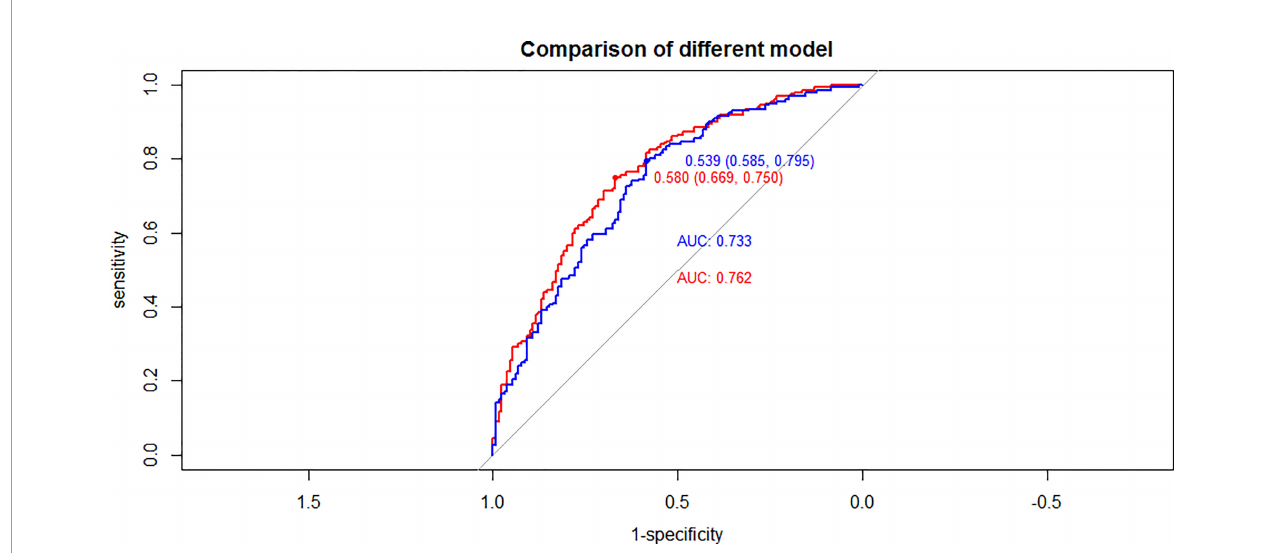
FIGURE 1 | Compared of ROC curves between univariate and multivariate analyses results in PTC(cT1a) patients (red line: multivariate analyses results, blue line: univariate analyses